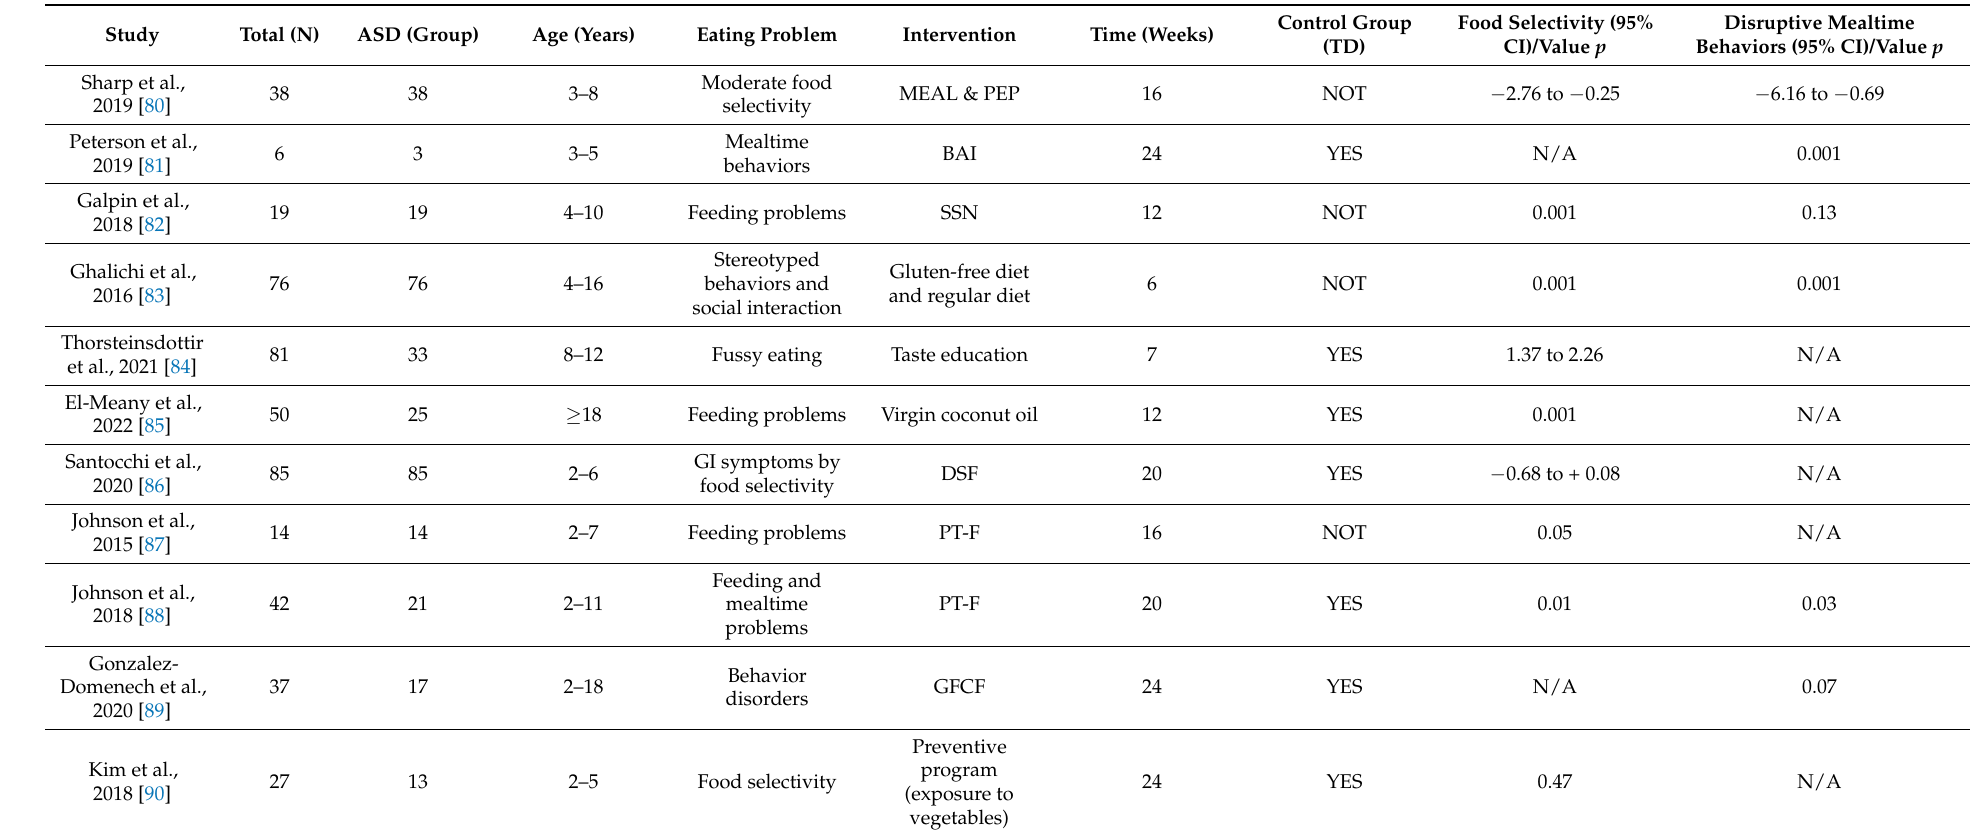
Table 4. Nutritional and behavioral clinical intervention studies in feeding